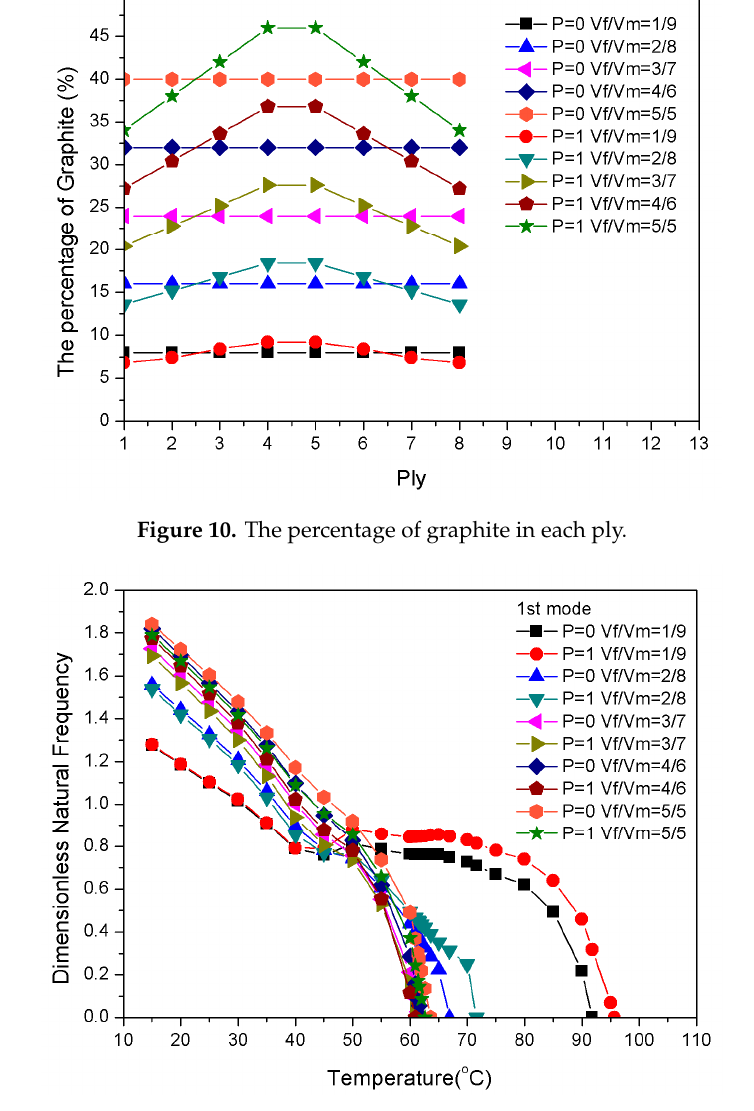
Figure 11. Dimensionless natural frequencies vs. temperature with variations of the substrate ratio. Table 4. Critical temperatures.